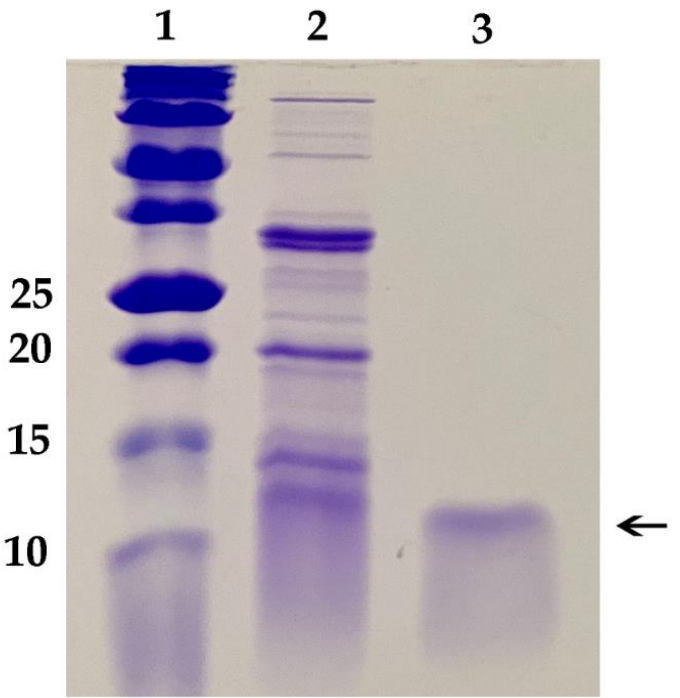
Figure 3. SDS polyacrylamide gel of purification of the E. festucae antifungal protein produced in Pe. chrysogenum . Lane 1, Bio-Rad Precision Plus Protein Dual Xtra Standards, size of markers in kD given on left; Lane 2, Crude culture filtrate of Pe. chrysogenum expressing the antifungal protein; Lane 3, 1 µg purified Efe -AfpA, indicated by the arrow.